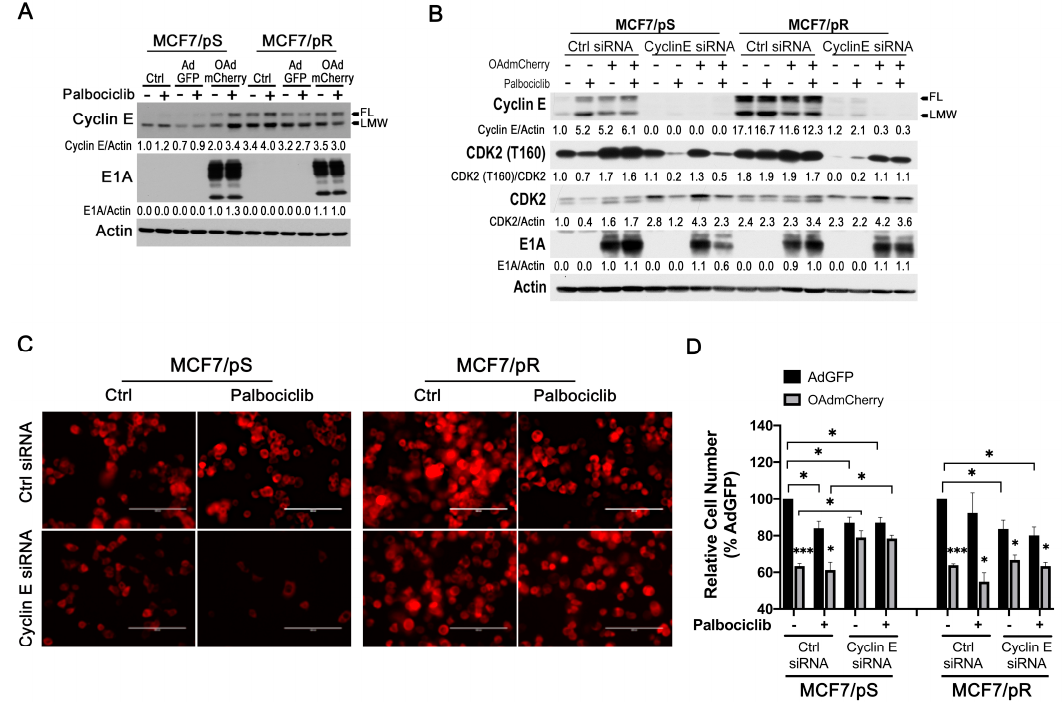
Figure 7. Cyclin E knockdown inhibits virus replication only in MCF7 / pS cells. ( A ) Cells were either left uninfected (Ctrl) or infected with AdGFP or OAdmCherry at a multiplicity of infection (MOI) concentration of five alone or in combination with 500 nM palbociclib for 24 h. Cyclin E and viral E1A expression was assessed by immunoblotting. ( B ) Cells were transfected with either control or a pool of cyclin E-specific siRNAs followed by AdGFP or OAdmCherry at a MOI concentration of five alone or in combination with 500 nM palbociclib for 24 h. Cyclin E expression and downstream signaling as well as expression of E1A viral protein was assessed by immunoblotting. Quantitative densitometry analysis is shown relative to loading control normalized to palbociclib-sensitive control-treated cells (except for E1A blots where samples were normalized to OAdmCherry Ctrl). ( C ) mCherry expression was evaluated by fluorescence microscopy. Scale: 200 µ m. ( D ) Cell number was assessed by crystal violet staining and calculated by measuring the absorbance of solubilized dye at 590 nm. Results are expressed as percent (%) of AdGFP vehicle-treated cells. Error bars, ± SEM of three independent experiments. * p < 0.05; *** p < 0.001; compared to control AdGFP unless otherwise